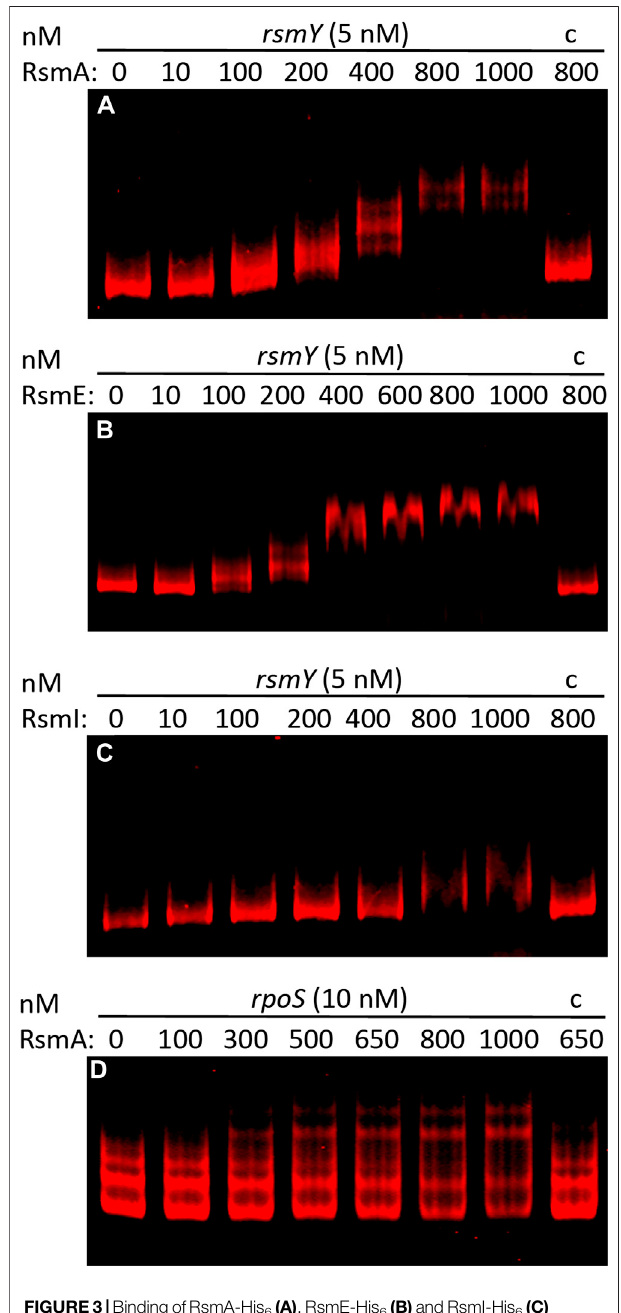
FIGURE3| BindingofRsmA-His 6 (A) ,RsmE-His 6 (B) andRsmI-His 6 (C) to full-length rsmY RNA transcribed in vitro , and of RsmA-His 6 to a synthetic RNA fragment comprising the untranslated upstream region of rpoS (D) . EMSAs were carried out using fl uorescently labeled RNA (5 or 10 nM) and incubated in the absence or presence of increasing concentrations of puri fi ed Rsm proteins, as indicate above each lane, or in the presence of 100- fold excess of unlabelled RNA competitor and the indicated concentration of protein (C)